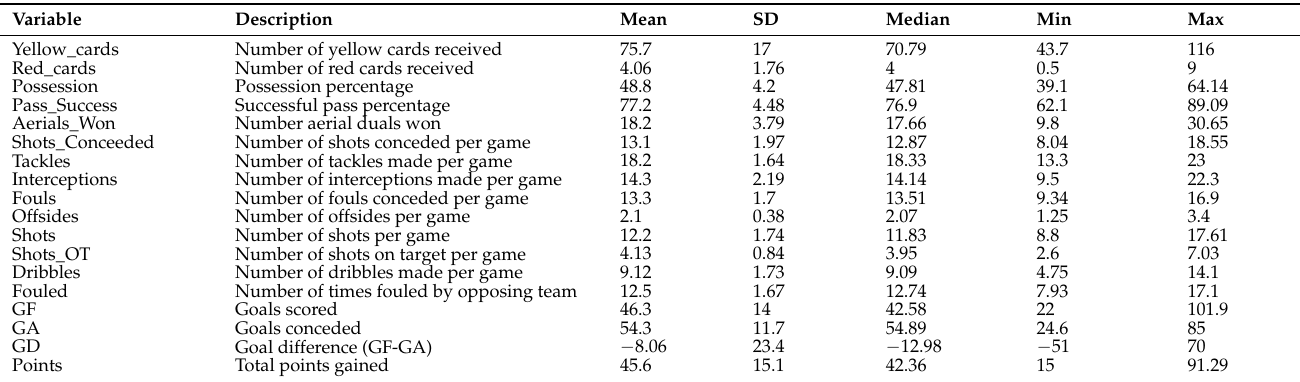
Table 1. Variable description and descriptive